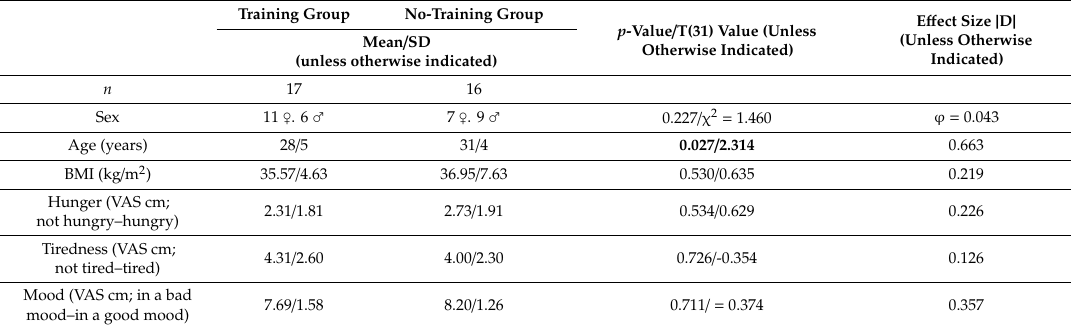
E ff ect Size | D | (Unless Otherwise Indicated)Mean / SD